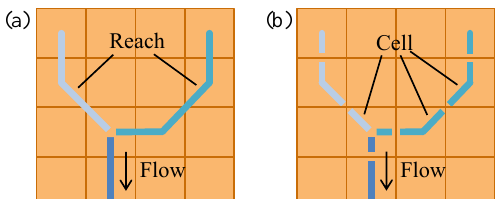
Figure 2. Available methods for spatially discretizing the stream reaches in StreamFlow: (a) the lumped approach, treating each stream reach as a lumped entity, and (b) the discretized approach, subdividing each reach into smaller entities called cells. Each stream reach is represented using a different shade of blue in the figure. The grid shown in brown corresponds to the DEM used by TauDEM to identify the subwatersheds and the stream